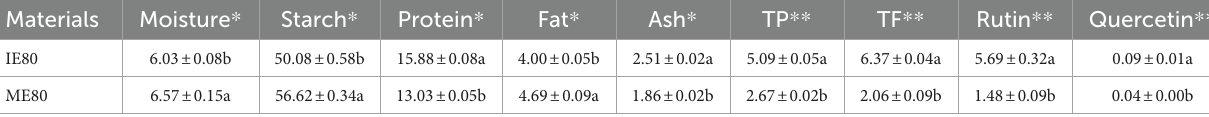
TABLE 2 Phytochemical compositions of different instant powder samples. Materials